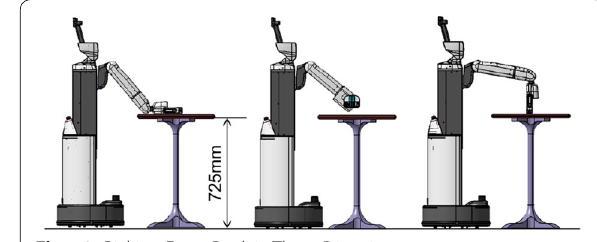
Fig. 13 Picking From Desk in Three Directions